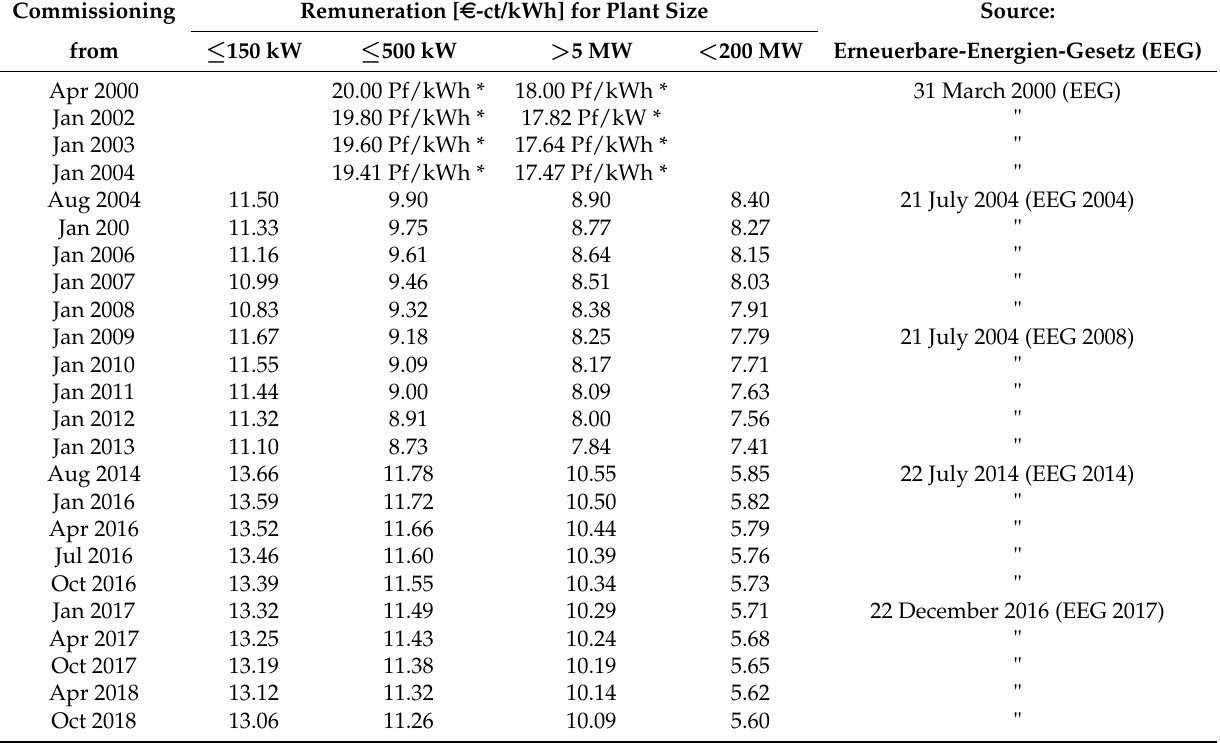
Table A2. Development of EEG remuneration for biomass power plants of different